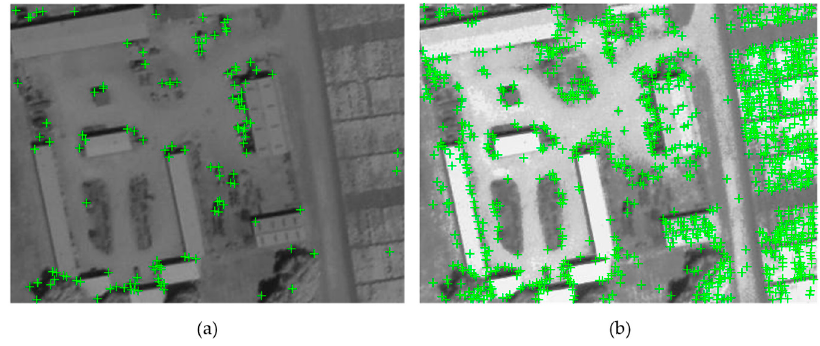
Figure 13. Comparison of feature points of NIR images before and after the histogram specification: ( a ) initial NIR grayscale image; ( b ) NIR grayscale image after histogram specification. The feature points represented by the green plus in ( b ) remarkably outnumbered those in ( a ).